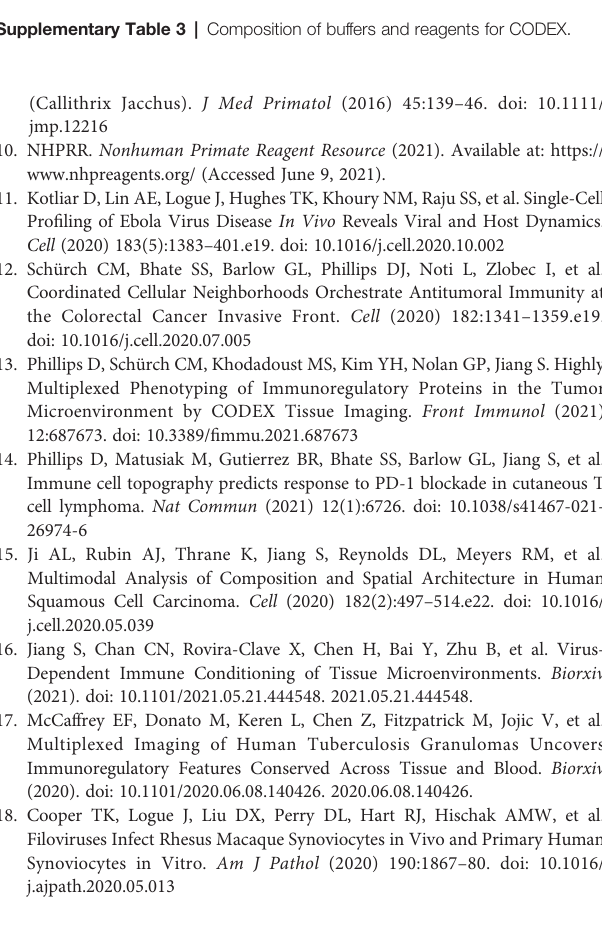
Supplementary Figure 1 | Immunohistochemistry validation of antibodies on human and rhesus immune tissues. Representative IHC images for indicated markers on human (left) and rhesus (right) tissues. Spleen tissue is shown unless otherwise indicated. *human spleen, rhesus bone marrow; ** human tonsil, rhesus lymph node. Supplementary Table 1 | Antibody panel information. Antibody, clone, supplier, product number, oligonucleotide number, oligonucleotide sequence, oligonucleotide channel, imaging order. Supplementary Table 2 | All antibodies tested in this study. Antibody, clone, Manufacturer reported reactivity, species, company, catalog number, manufacturer recommendation for IHC, dilutions tested for IHC, pass/fail of antibody in our validation pipeline. Supplementary Table 3 | Composition of buffers and reagents for